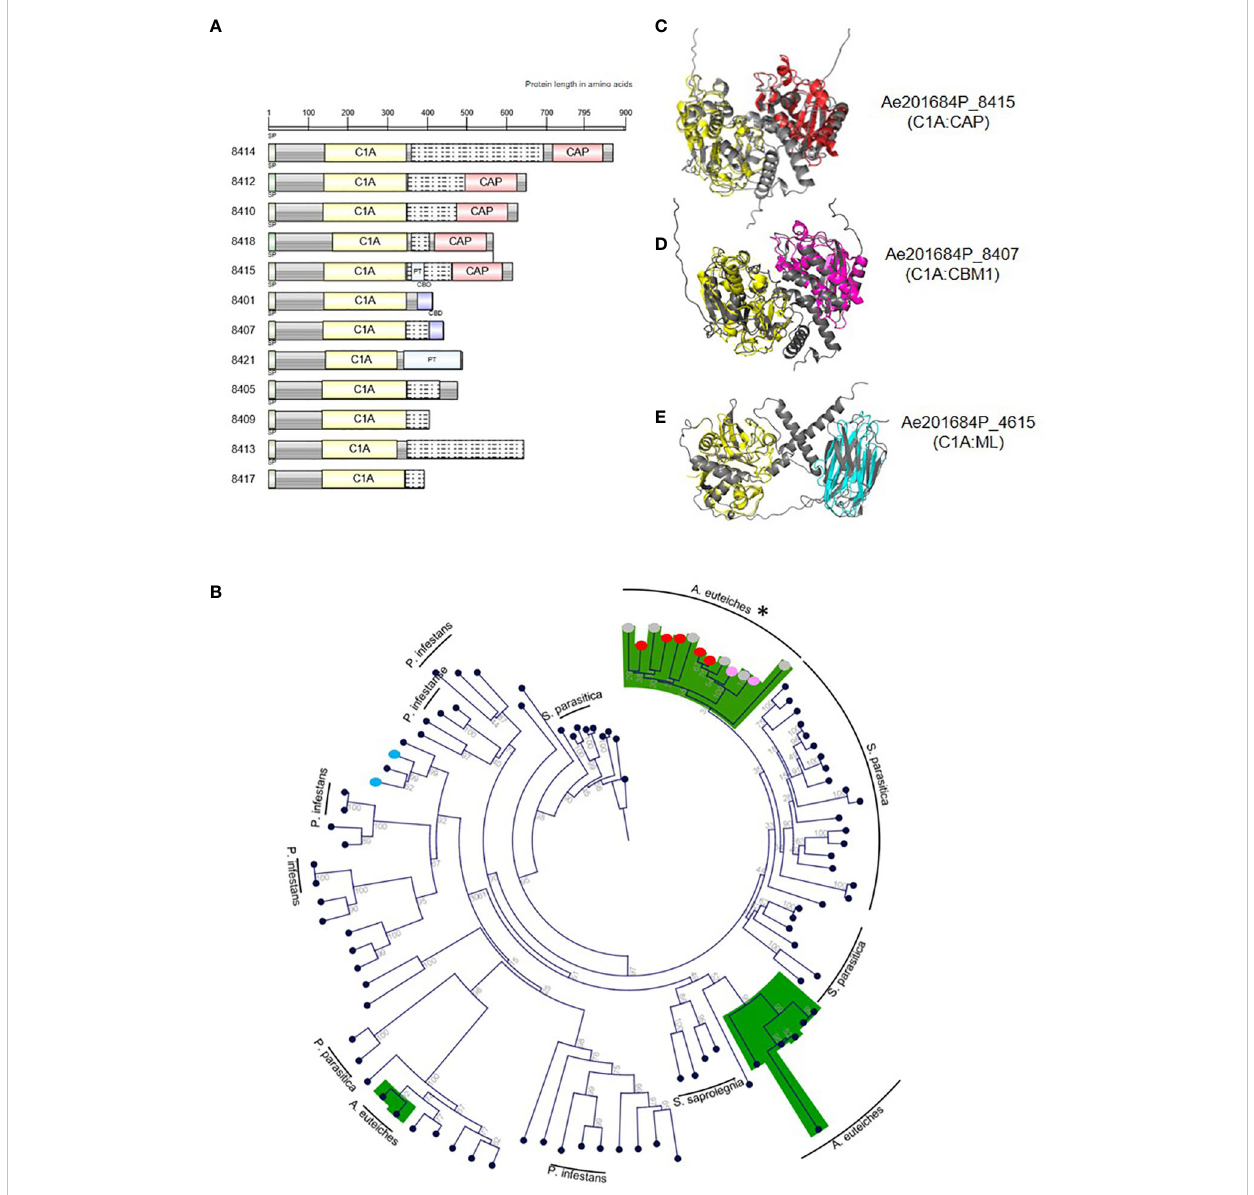
FIGURE 4 Modular papain-like cysteine proteases (PLCP) from A. euteiches identi fi ed in pea apoplastic fl uids. (A) Protein domain architecture of the clustered PCLPs from A. euteiches. C1A: cysteine protease domain type C1A (PF00112); CBD: carbohydrate-binding module CBM1 (PF00734), CAP: Cysteine- rich secretory protein (PF00188), PT: PT-repeat (PF04886). Grey boxes: no domain predicted, Grey boxes with dashed lines: disorder region predicted by InterProScan. Scale = amino acids. (B) Phylogenetic tree constructed using the predicted C1A domain (PF00112) present in PLCPs from the plant pathogen Phytophthora infestans , the animal pathogen Saprolegnia parasitica and A. euteiches . Green color indicates the main group for A. euteiches. Asterik identi fi ed the clustered extracellular PCLPs of the pathogen. Colored dots indicated the associated domain of multidomain PLCPs of A. euteiches (red: CAP; pink: CBD; blue: ML-domain; grey: no domain). Neighbor-Joining method was used and boostrap are indicated (C-E) . PyMol representation of selected A. euteiches modular C1A cysteine proteases (grey). 3D structures superposition with a reference domain (colored) was performed, (C) Ae201684P_8415, cysteine protease C1A (PDB 1BP4, yellow), CAP domain (PDB 1SMB, red). RMSD scores: C1A domains = 0.877, CAP-domains = 1.077; (D) Ae201684P_8407, cysteine protease C1A (PDB 1BP4, yellow), CBM1 domain (PDB 5X34, magenta). RMSD scores: C1A domains 0.787, CBM1-domains = 0.937; (E) Ae201684P_4615, cysteine protease C1A (PDB 1BP4, yellow), ML-domain (PDB 1AHM, cyan). RMSD scores: C1A domains 0.674, ML-domains = 4.475. Structural predictions were performed using